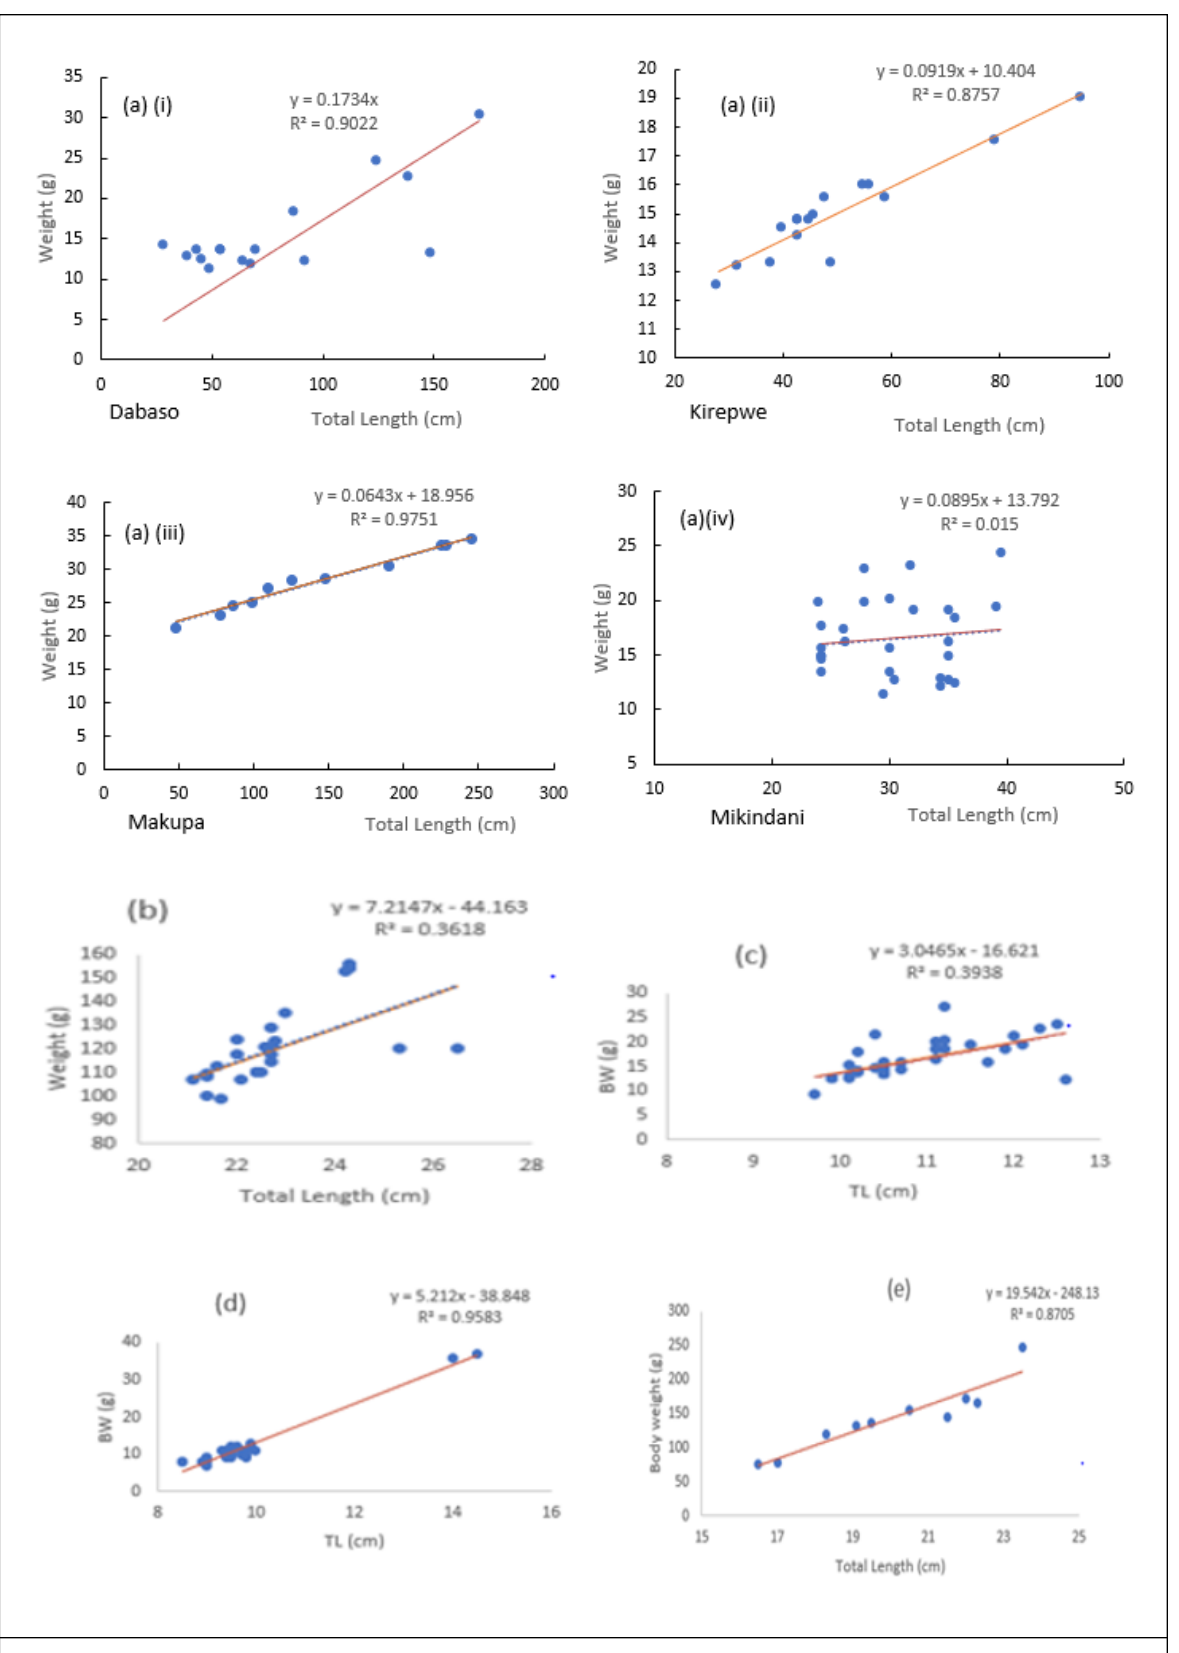
Figure 2: Von Bertalanffy growth curves fitted to the length-weight data for (a) Gerres oyena, (b) Rastrelliger kanagurta, (c)Terapon jarbua, (d) Acanthopagrus berda, (e) Leptoscarus vaigiensis from the creeks along the Kenya